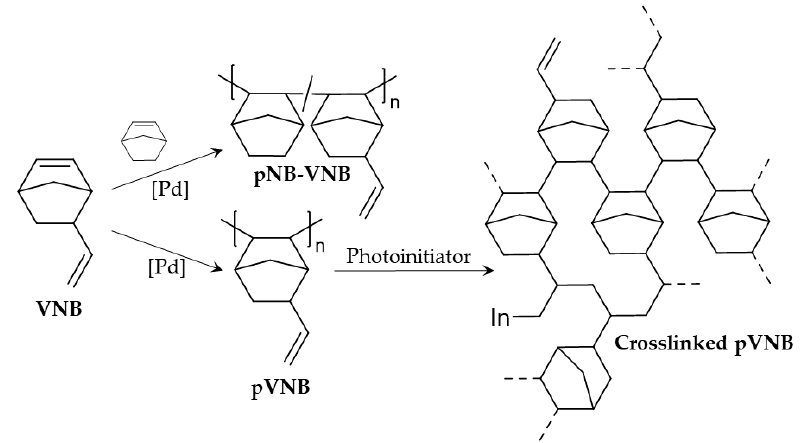
Figure 1. The structure of VNB, pVNB, copolymers pNB-VNB and crosslinked pVNB.